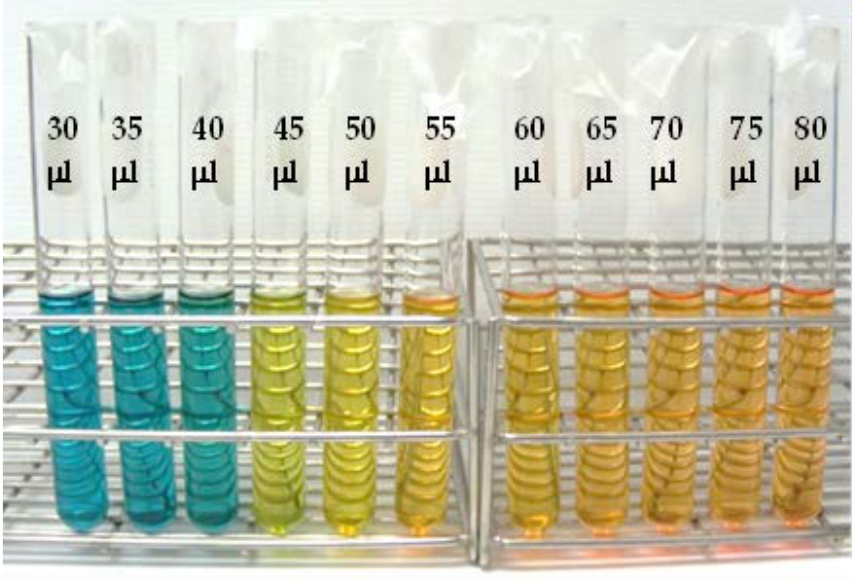
Figure 1. Colorimetric changes of indicator solution with addition of different concentrations (30, 35, 40, 45, 50, 55, 60, 65, 70, 75, and 80 µL) of 0.1 M acetic acid .